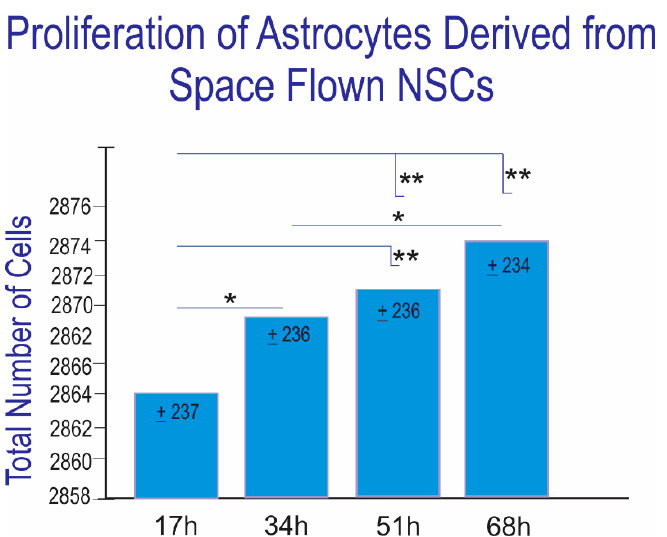
Figure 5. After 39.3 days in space, astrocytes derived from SPC-flown NSCs, increased their numbers slowly, steadily and in a significant manner with time in culture. Between one and 2 cells divided in an interval of 17 h. Values are expressed as mean + SD (shown inside the corresponding bar per time point) of three separate experiments. * p < 0.05, ** p < 0.01.